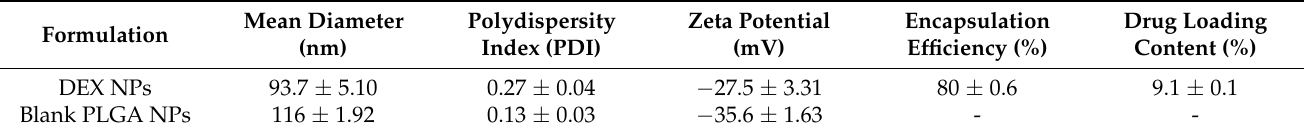
Table 1. Physicochemical properties, encapsulation efficiency, and drug loading content of blank and DEX-loaded PLGA NPs ( n = 3, mean ± s.d.).